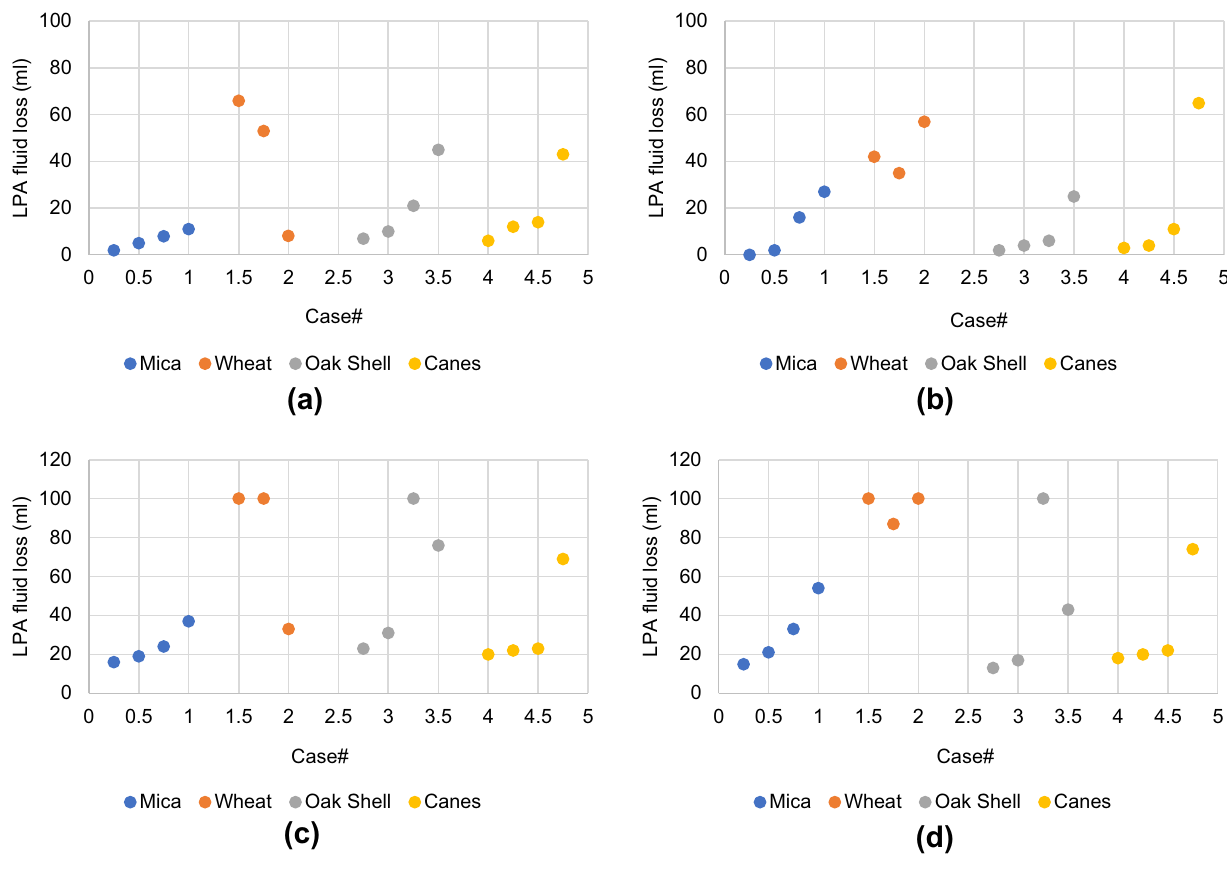
Fig. 32 The effect of PSD on fluid loss using C1 & C2 at high & low LCM